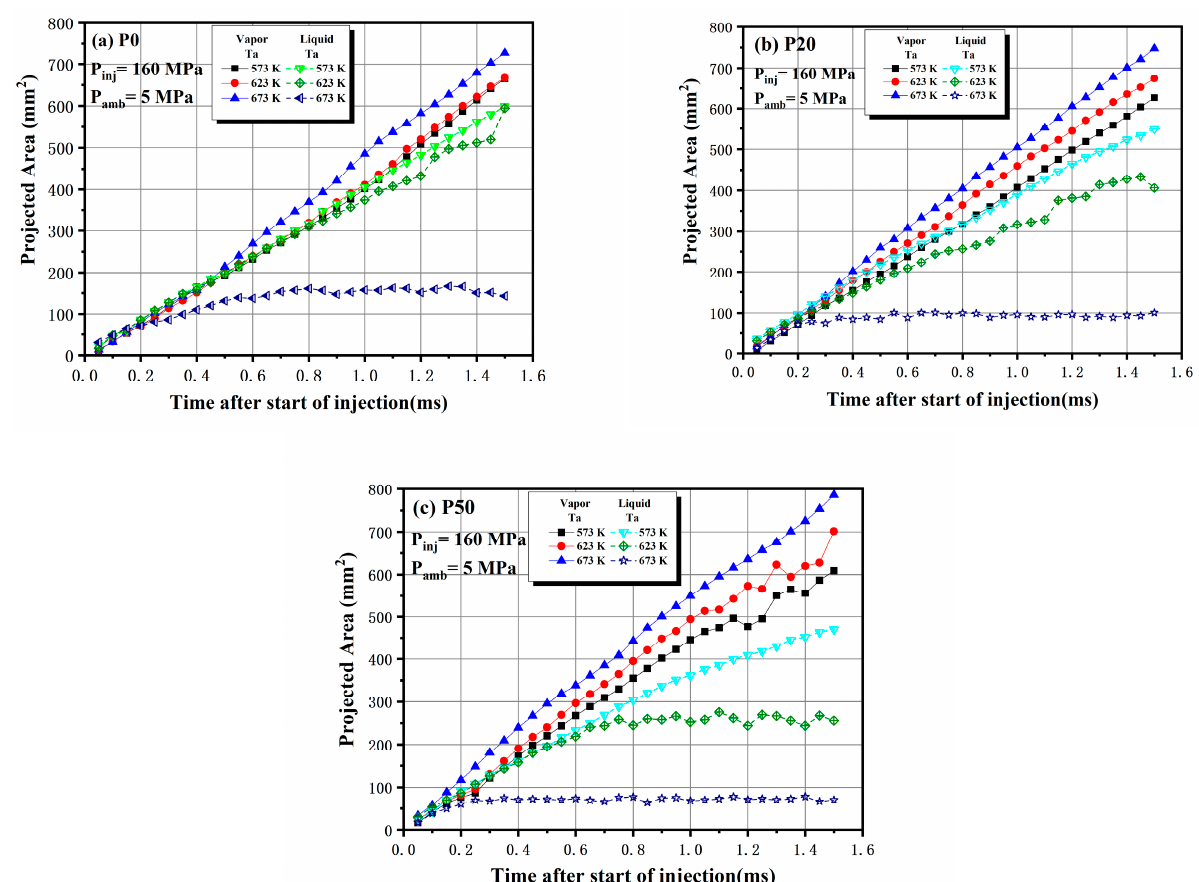
Figure 9. Projection areas of the three fuels at different ambient temperatures: ( a ) P0, ( b ) P20, ( c ) P50.